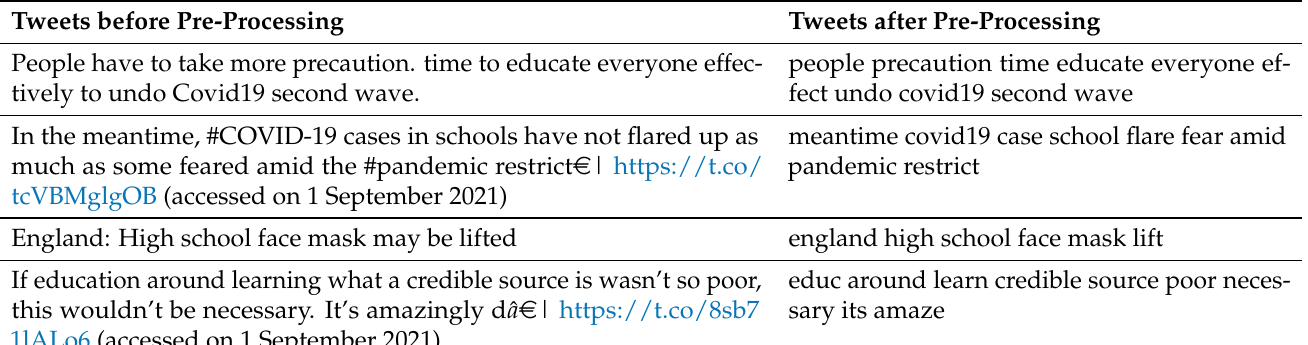
Table 4. Sample tweets from the dataset before and after preprocessing.